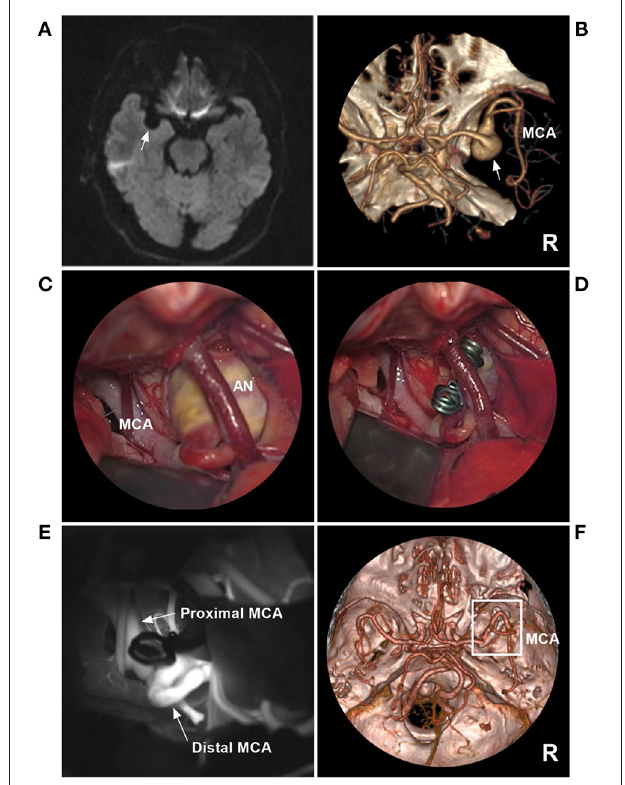
FIGURE 7 | PAO with the assistance of low-flow bypass in a VA fusiform AN. (A) CT showed subarachnoid hemorrhage around the brainstem. (B) DSA of the left VA showed that the VA was normal. (C,D) DSA (C) and three-dimensional DSA (D) of the right VA showed the fusiform AN above the origin of the PICA. (E,F) CTA showed PAO under the assistance of low-flow bypass. (E) the OA entered the cranium through the bone window. (F) the OA was anastomosed with the PICA trunk (arrow), and the AN was trapped with the clips. AN, aneurysm; CT, computed tomography; CTA, computed tomography angiography; DSA, digital subtraction angiography; OA, occipital artery; PICA, posterior inferior cerebellar artery; L, left; PAO, parent artery occlusion; R, right; VA, vertebral artery.